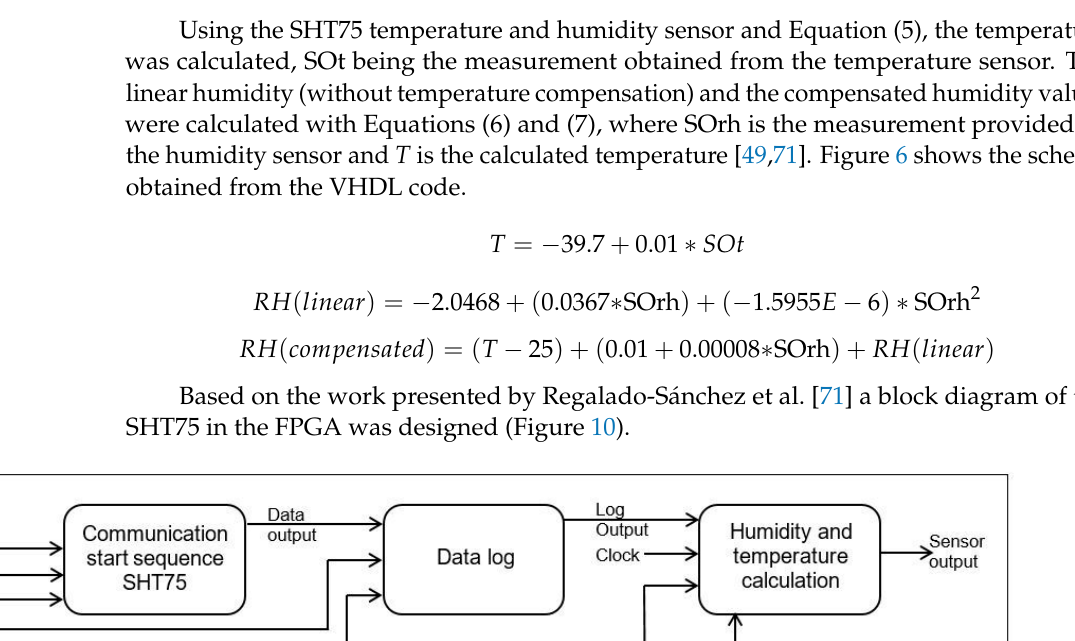
Figure 9. Comparison of the behavior of measurements made with the FLUKE infrared thermome- ter and with the TMP006 sensor. In total, 387 measurements were made in the range from 16 to 50 °C.